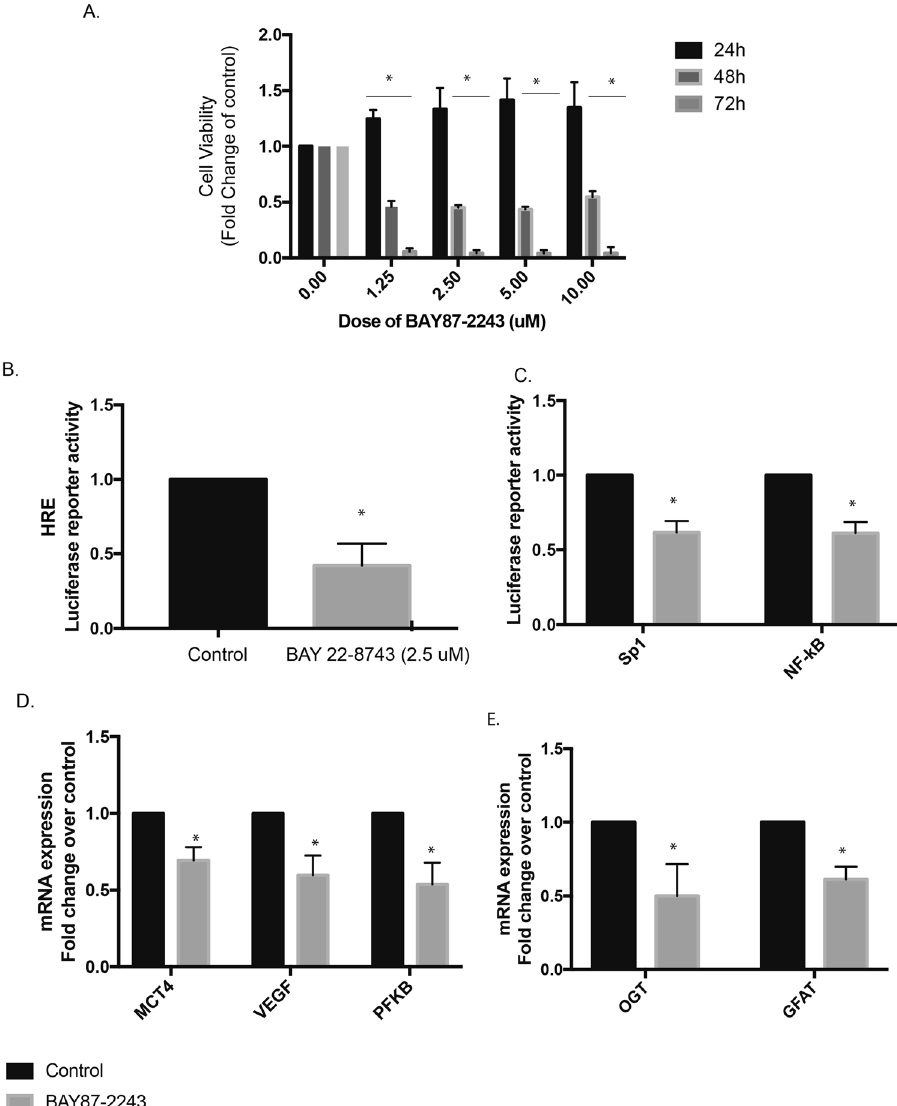
Figure 5. Inhibition of hypoxia leads to decreased oncogenic signaling. Treatment with BAY872243 decreased viability of pancreatic cancer cells ( A ) and HIF1A transcriptional activity by luciferase reporter assay ( B ). In addition, this also decreased the NF-kB and Sp1 transcriptional activity in these cells ( C ). Treatment with BAY 87-2243 also decreased the mRNA of VEGF, MCT4 and PFKB1, known targets of HIF1A ( D ). In addition, treatment with BAY87-2243 also decreased the expression of OGT and GFAT, the enzymes responsible for Sp1 and NF-kB transcriptional activity ( E ). All experiments were at least 3–5 times * indicates p-value <